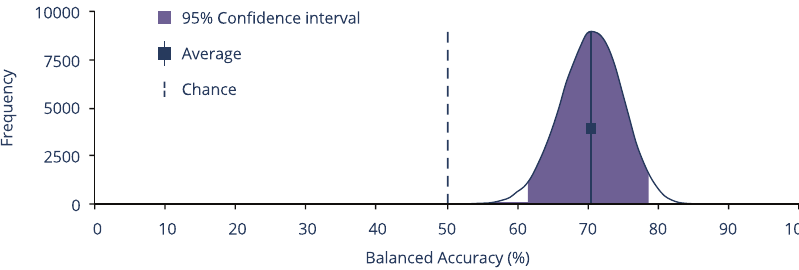
Statistics table describing the success of the algorithm in predicting response and no-response per medication in the fi nal STAR*D test set. n = 251 (citalopram), n = 24 (venlafaxine), n = 24 (sertraline). Standard deviations are given within